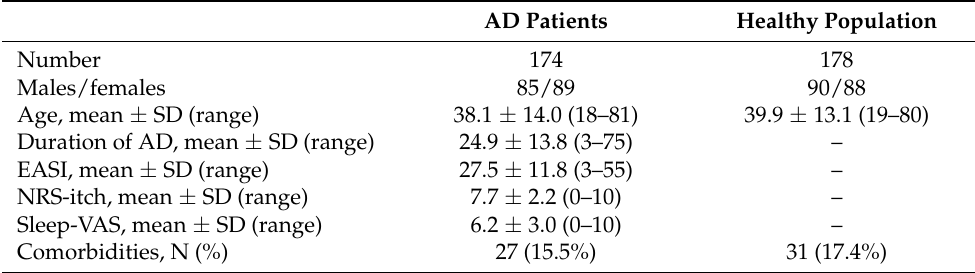
Table 1. Demographics and disease